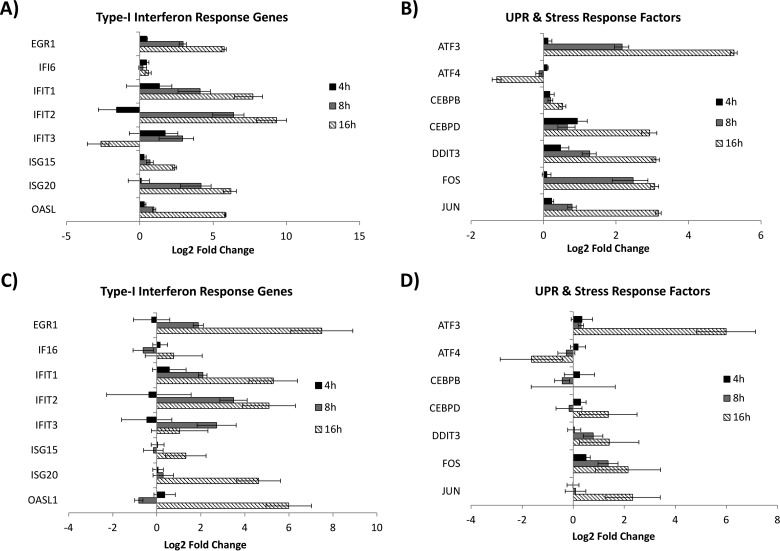
Next-generation RNA-Seq results and results of confirmatory qRT-PCR analysis. (A and B) RNA-Seq data for interferon response genes (A) and UPR and stress response genes (B). The data shown in panels A and B are log2-transformed values of the fold change of normalized gene expression (RPKM). Error bars are the ratiometric standard deviations of a two-component log function (VEEV-infected cells/mock-infected cells). (C and D) RNA was extracted using a miRVana kit, and gene expression was determined by qRT-PCR using TaqMan assays for interferon response genes (C) or for UPR and stress response genes (D). The data shown in panels C and D are log2-transformed values of the fold change of normalized gene expression determined by the ΔΔCT threshold cycle (CT) method.